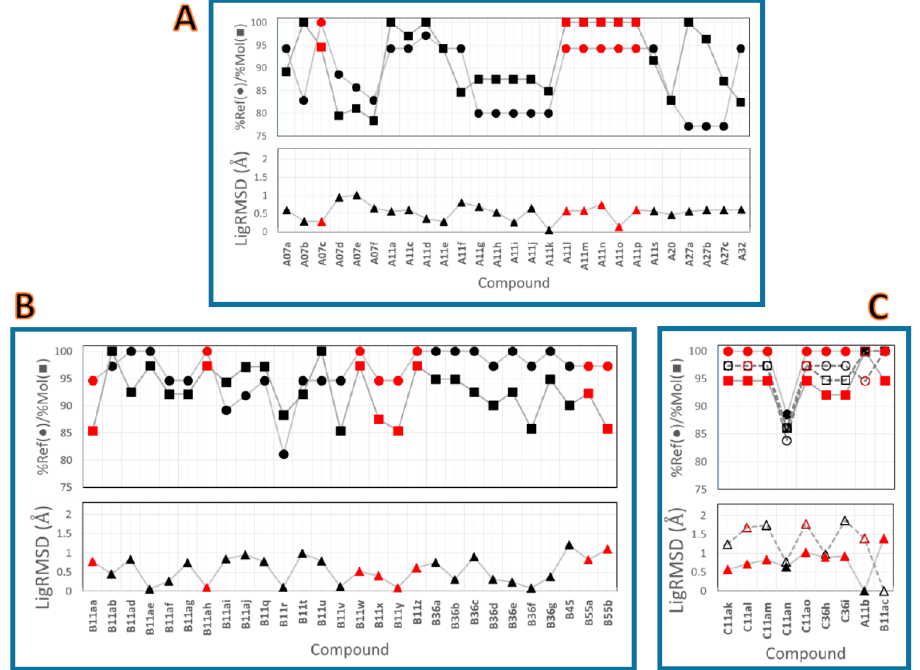
Figure 2. LigRMSD values for compounds from series A ( A ), B ( B ), and C ( C ). The LigRMSD values are represented by triangles, the %Ref match values are represented by circles, and the %Mol match values are represented by squares. Red markers indicate that the flexible mode was used for the LigRMSD calculation. ( C ) also includes LigRMSD, %Ref match, and %Mol match values for A11b and B11ac . In ( C ), closed triangles, circles, and squares represent LigRMSD, %Ref match, and %Mol match values relative to the reference A11b , respectively, and open triangles, circles, and squares represent LigRMSD, %Ref match, and %Mol match values relative to the reference B11ac , respectively.